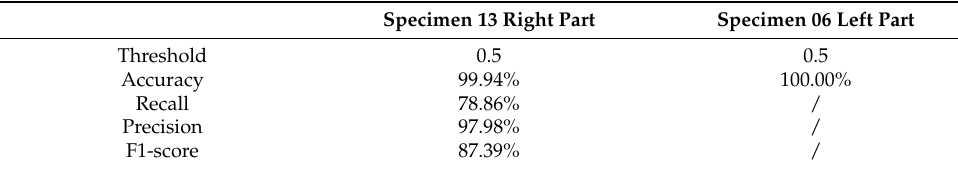
Table 6. Deep model’s evaluation results on LWIR testing